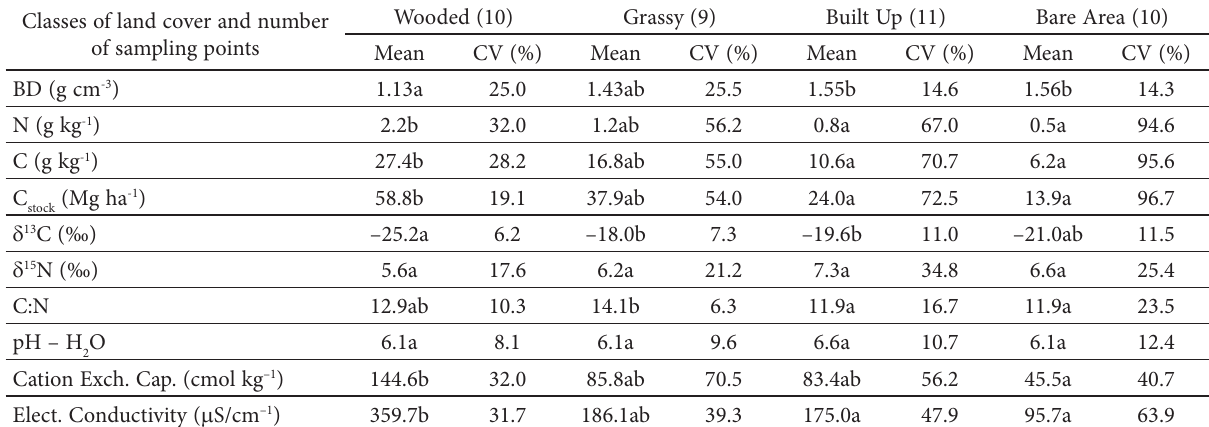
Table 4. Soil attributes according to land cover classes (N = 40). For each variable, different letters mean difference significant at P = 5%. Identical letters mean no significant difference among the classes at P = 5% Classes of land cover and number of sampling points